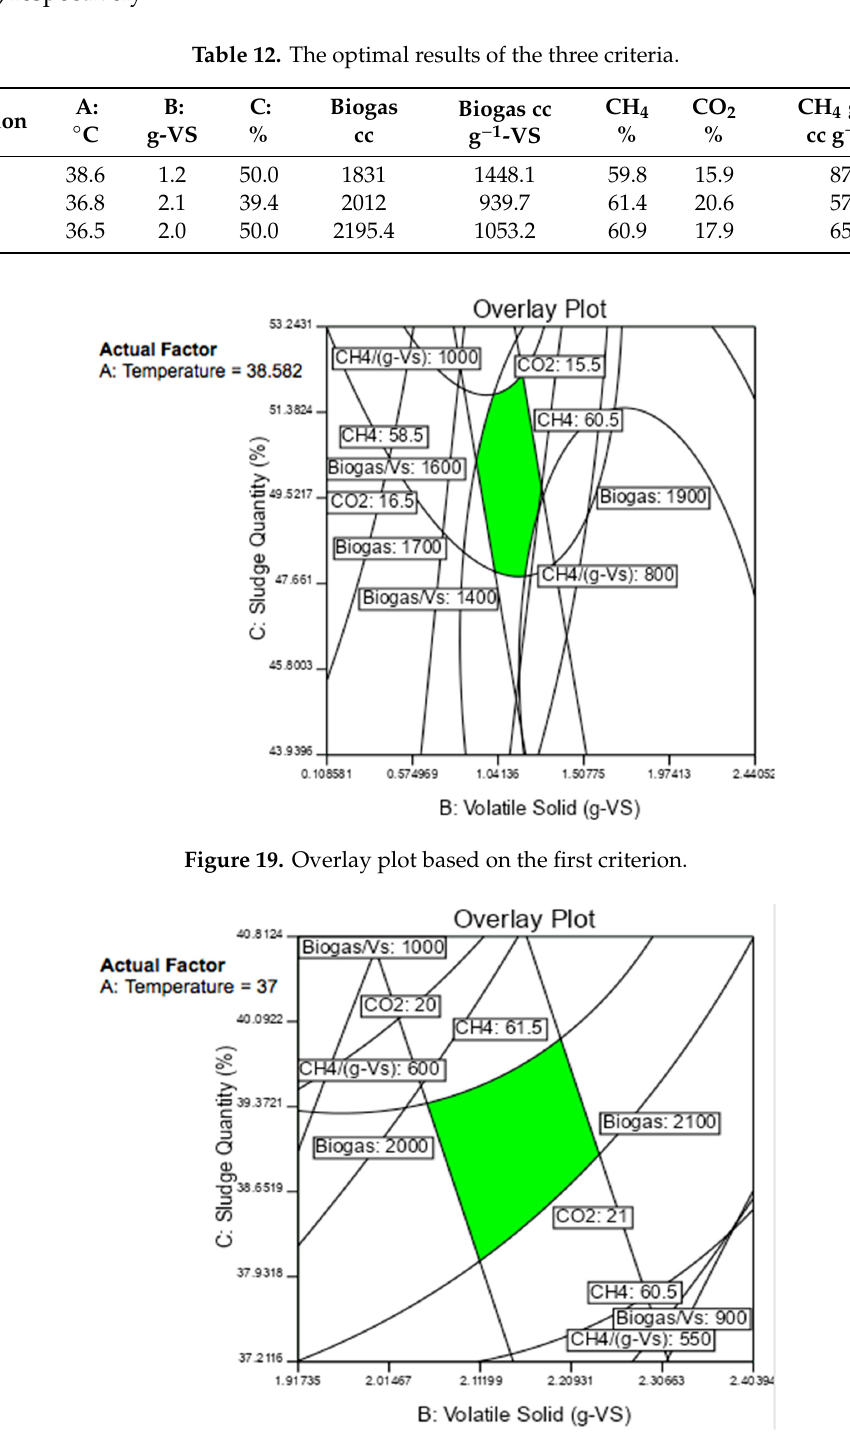
Figure 21. Overlay plot based on the third criterion. Table 13. Energy evaluation of the optimisation criterion. Criterion